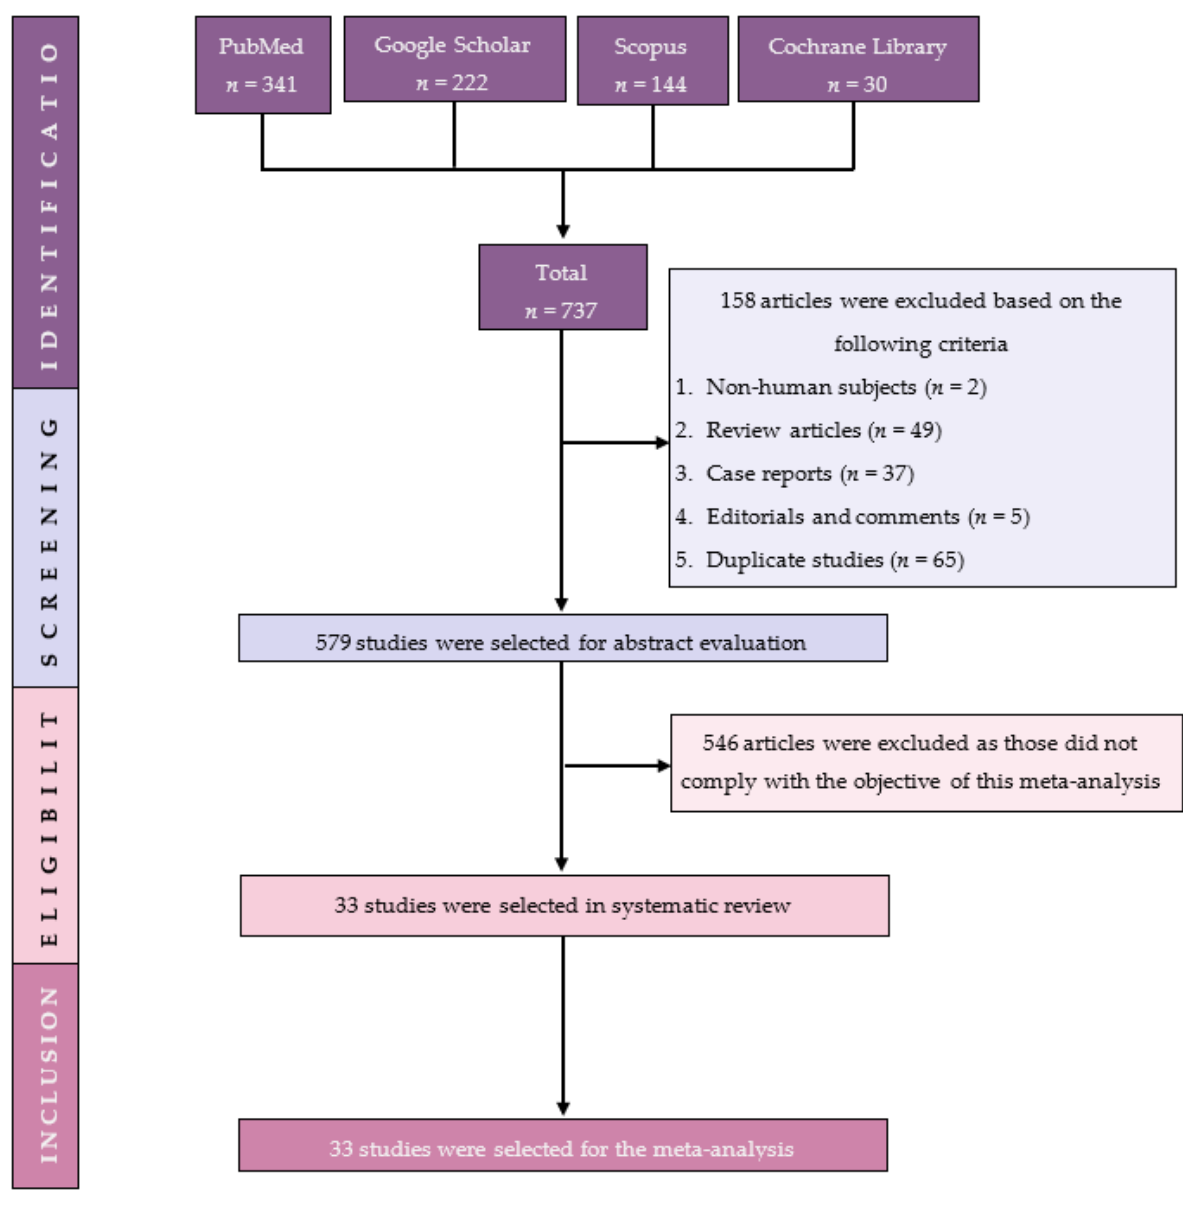
Figure 1. PRISMA flow diagram of study selection.